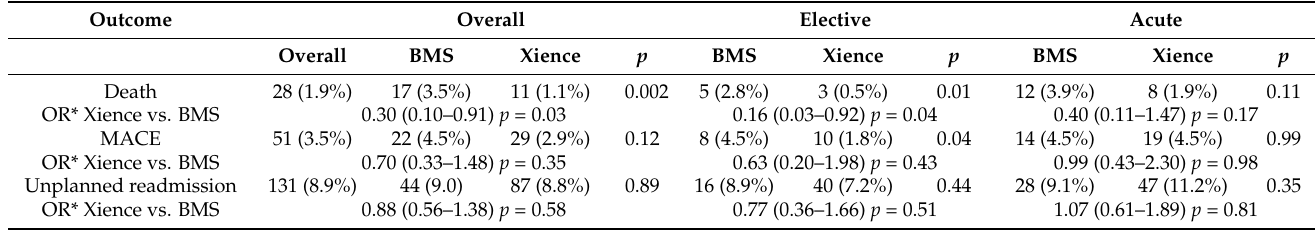
Table 4. 1-year Outcomes for BMS vs, Xience DES by